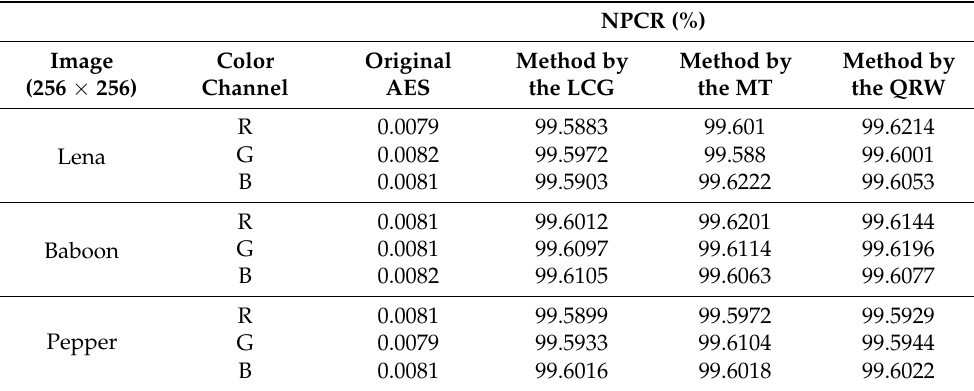
Table 7. NPCR result of the original AES and the proposed methods.